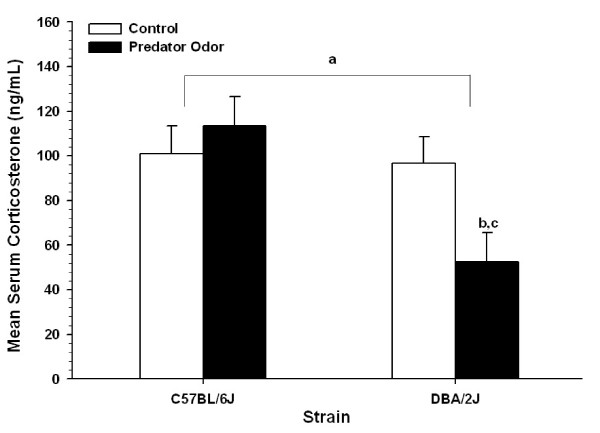
Serum corticosterone levels (ng/mL) among C57BL/6J (N = 23) and DBA/2J (N = 24) control (□; N = 24) or predator odor-exposed (■; N = 23) mice (adjusted means + standard error of the mean). aStrain effect (DBA/2J < C57BL/6J, p < 0.05); bStrain X Odor Exposure interaction (Odor-exposed DBA/2J < Odor-exposed C57BL/6J, p < 0.05); cStrain X Odor Exposure interaction (Odor-exposed DBA/2J < Control DBA/2J, p < 0.05).